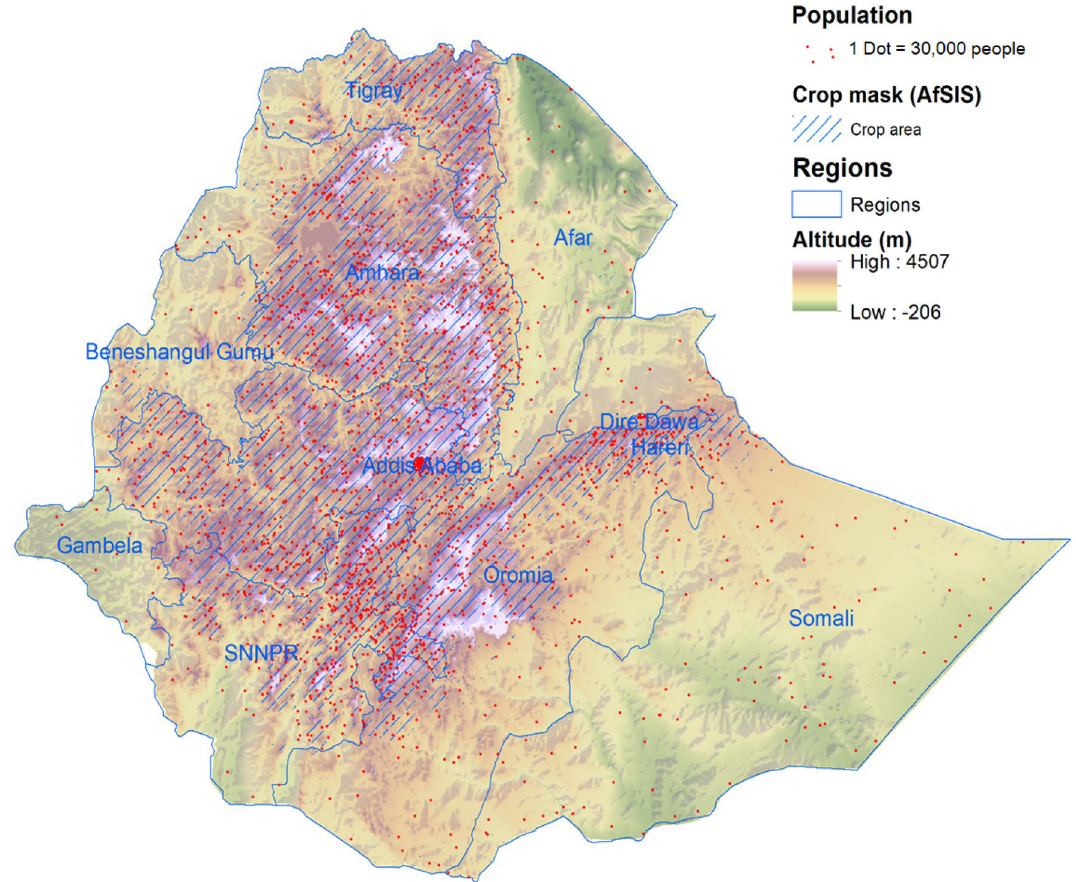
Figure 3. Population, altitude and crops in Ethiopia (map produced with ArcGIS Desktop version 10.8.1 from ESRI, https:// www. esri. com/ en- us/ arcgis/ produ cts/ arcgis- deskt op/ overv